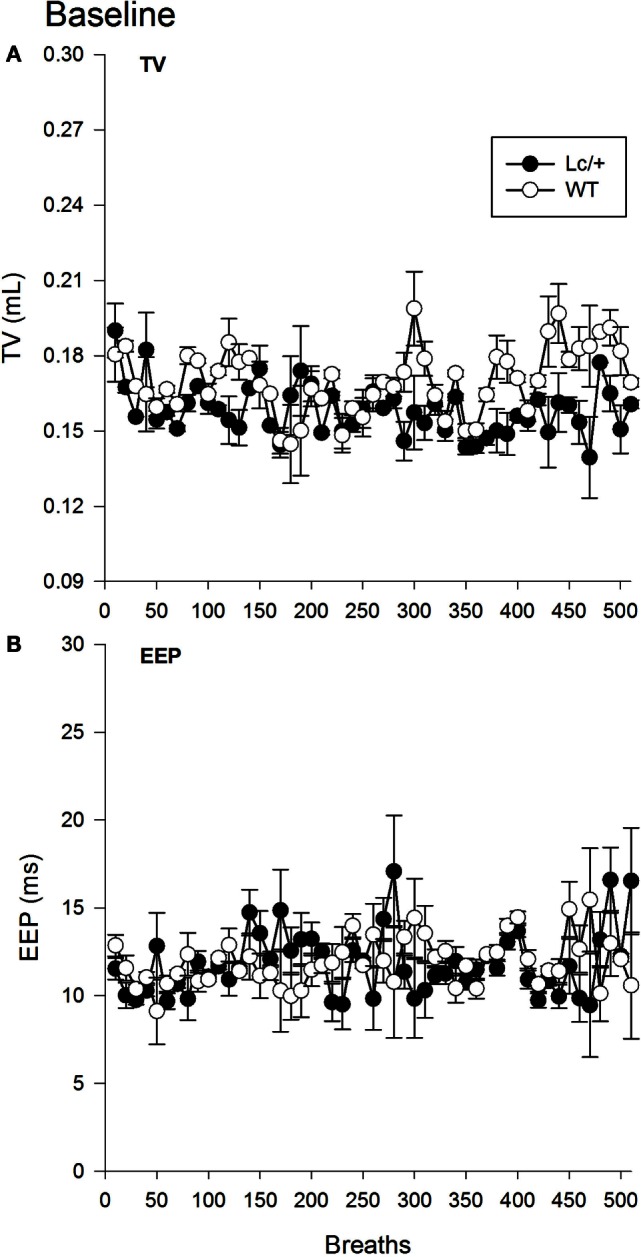
Baseline tidal volume (A) and end-expiratory pause (B) data for 510 breaths at normal room air in Lurcher mutant (Lc/+) and wild-type (WT) control mice. Breaths have been averaged into groups of 10 for clarity of presentation. Values represent mean ± SEM.